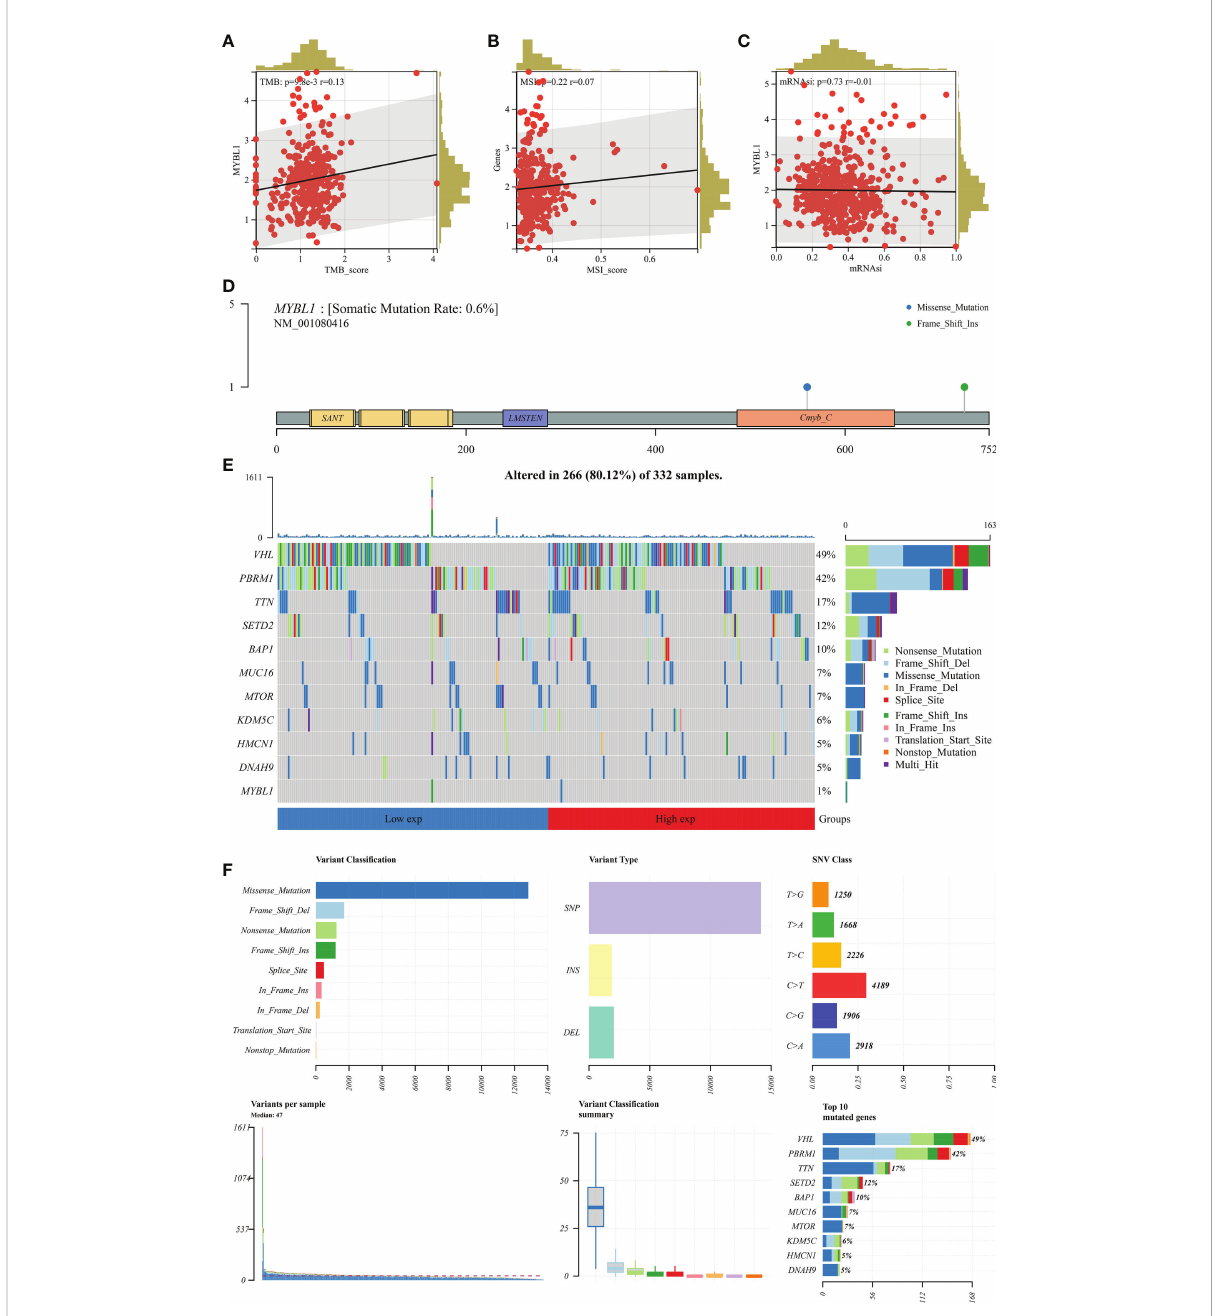
FIGURE 4 Genomic characteristics of MYBL1. (A) Correlation of MYBL1 with TMB; (B) Correlation of MYBL1 with MSI; (C) Correlation of MYBL1 and mRNAsi; (D – F) The mutation characteristics of